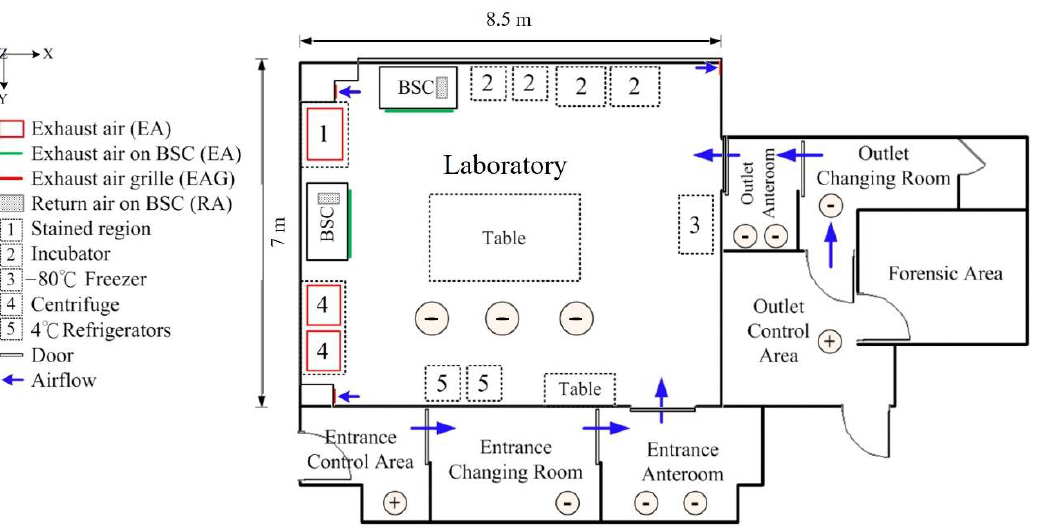
Figure 1. The layout of the investigated BSL-3 laboratory.